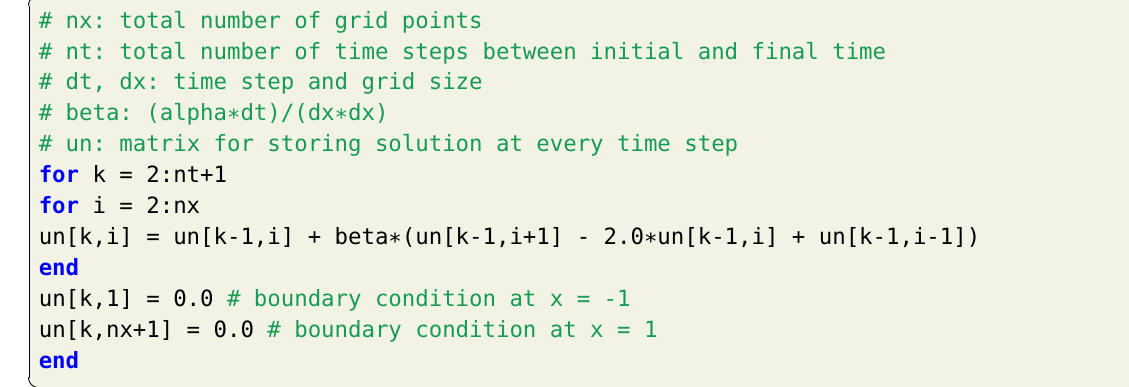
Listing 1. Implementation of FTCS numerical scheme for heat equation in Julia.